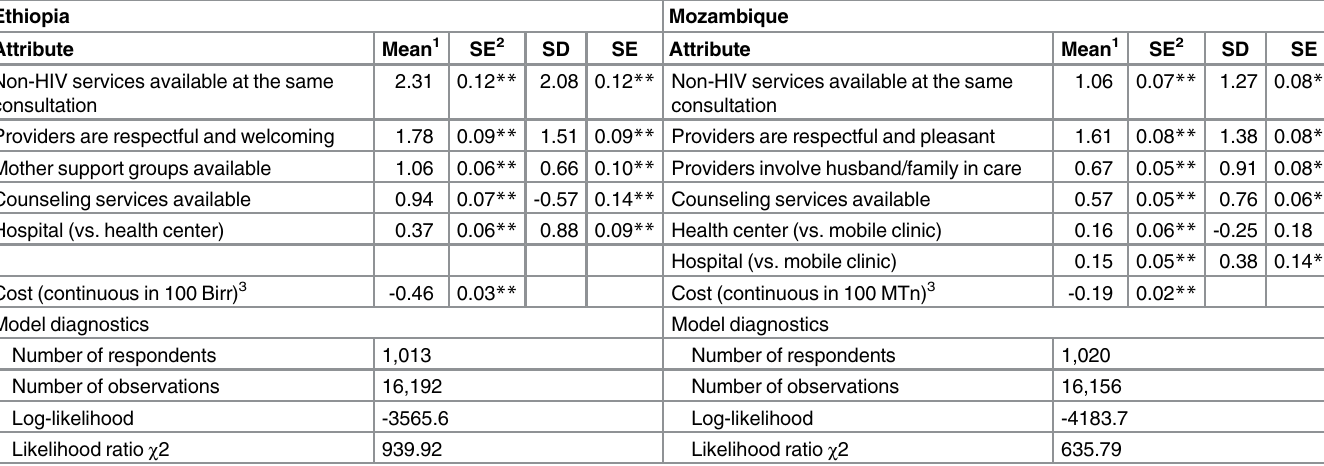
Table 4. Results of mixed logit regression